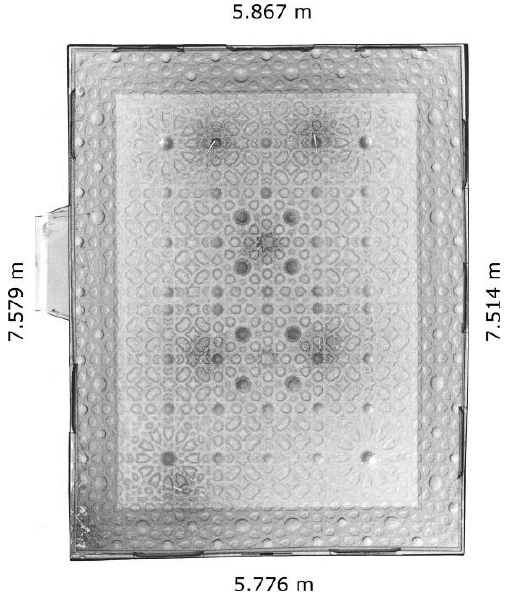
Figure 15. Ceiling dimensions from point cloud (orthogonal projection).